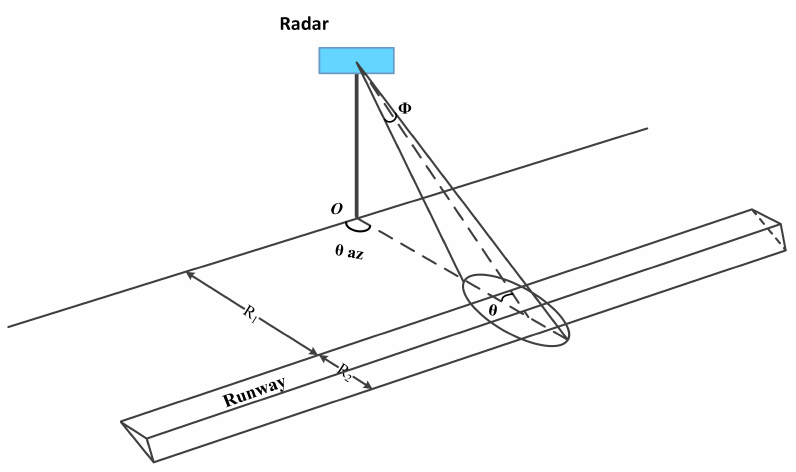
Figure 1. Geometry of FOD radar